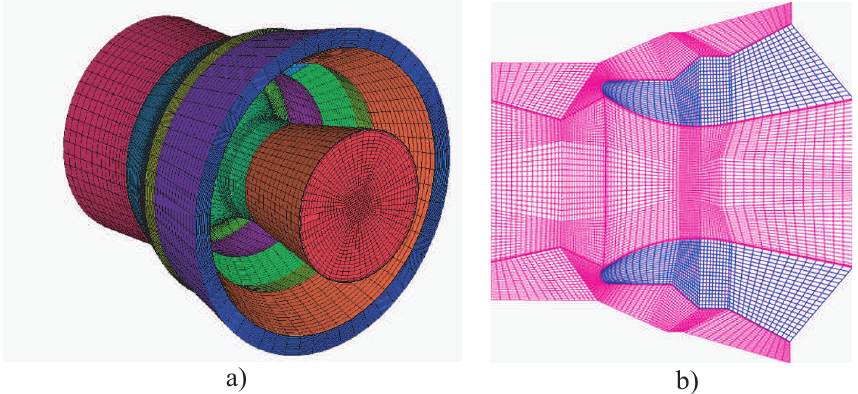
Figure 3. Mesh in nozzle block ( a ) and mesh in the meridional section ( b